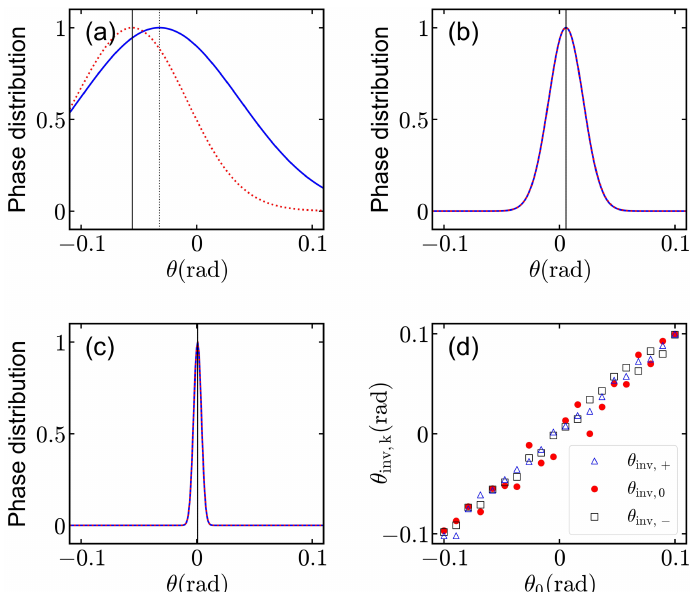
Figure 4. Given the true value of the phase shift θ 0 = 0, phase distribution P ( θ |{N k } ) (red dashed) and its approximate result (solid) as a function of θ , simulated with N random numbers for ( a ) N = 5, ( b ) N = 50, ( c ) N = 1000. ( d ) The inversion estimators of the three-outcome homodyne detection for different values of θ 0 . Parameters: a = 0.183 and the others the same with Figure